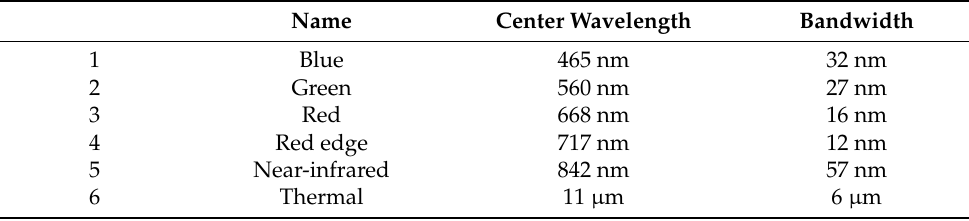
Table 1. The center wavelengths and bandwidths for the MicaSense Altum multispectral